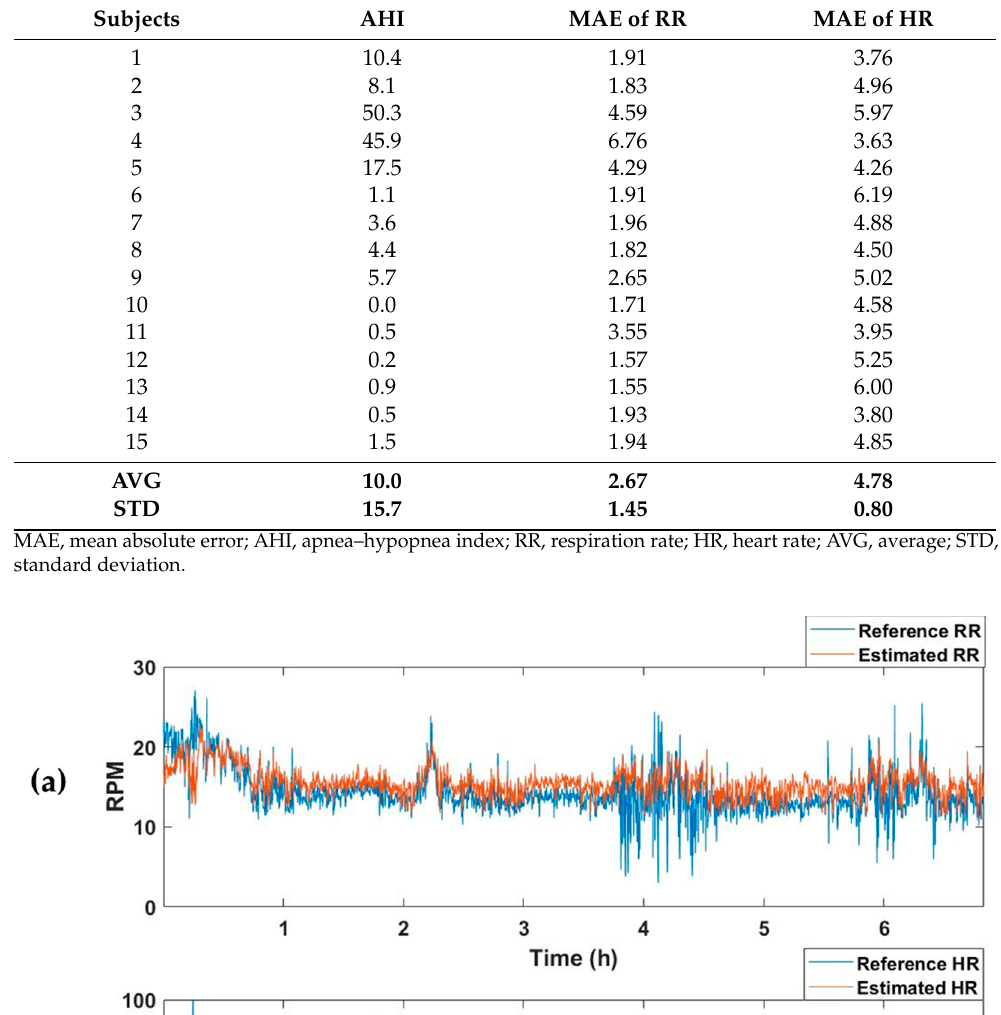
Table 3. MAE test results for each subject.